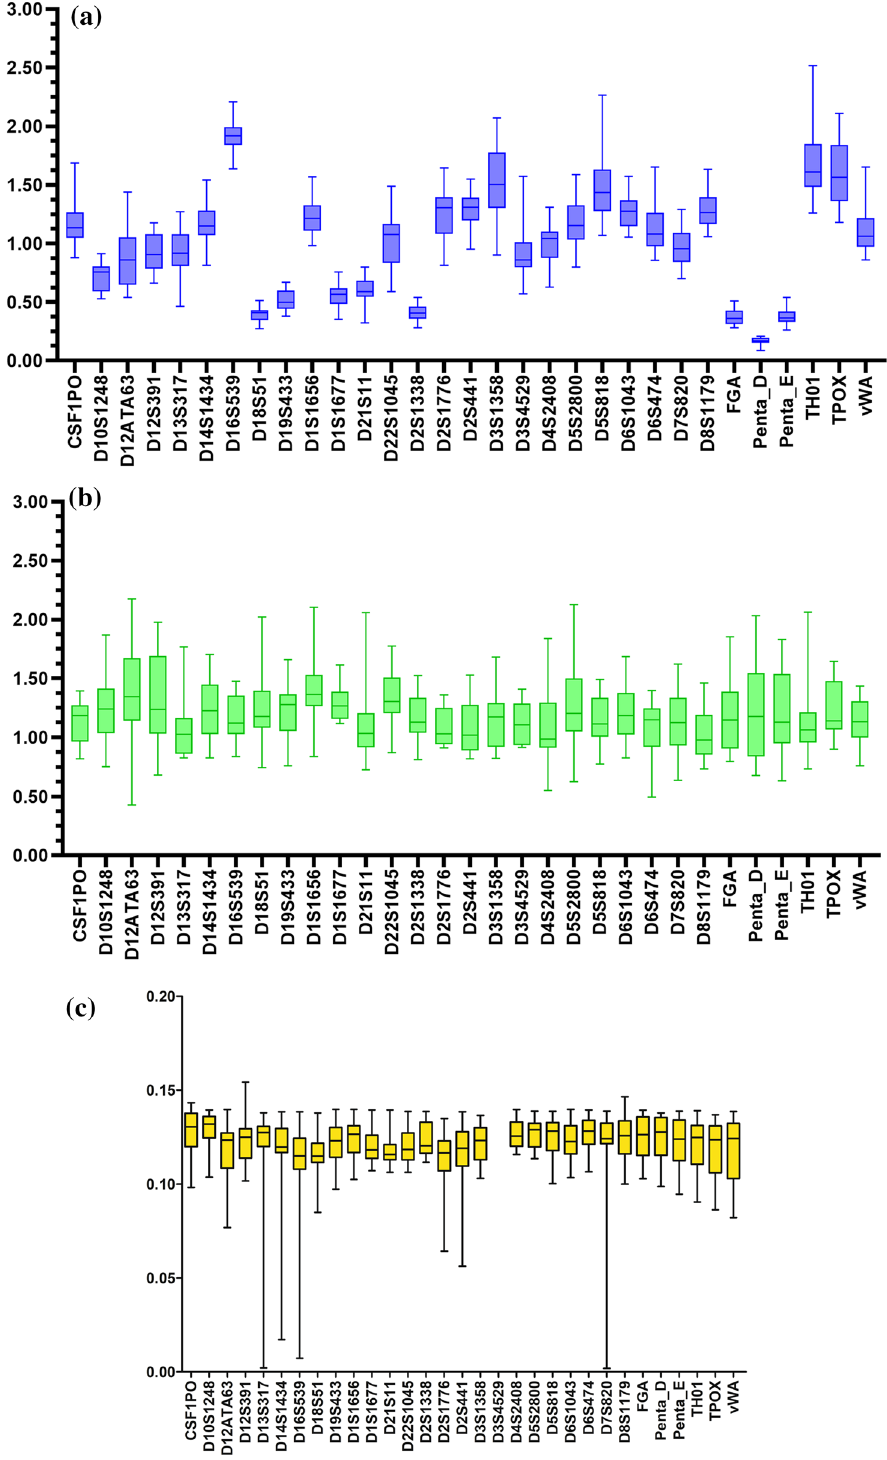
Figure 2. Sequence performance of Precision ID NGS STR panel v2. ( a ) Locus Balance for all STRs measured as coverage of each locus divided by average coverage of all locus per sample. ( b ) Heterozygous Balance for all STRs measured as coverage ratio of one allele to another, for heterozygous genotypes only. ( c ) Stutter ratio measured as ratio of coverage of stutter peak and allele